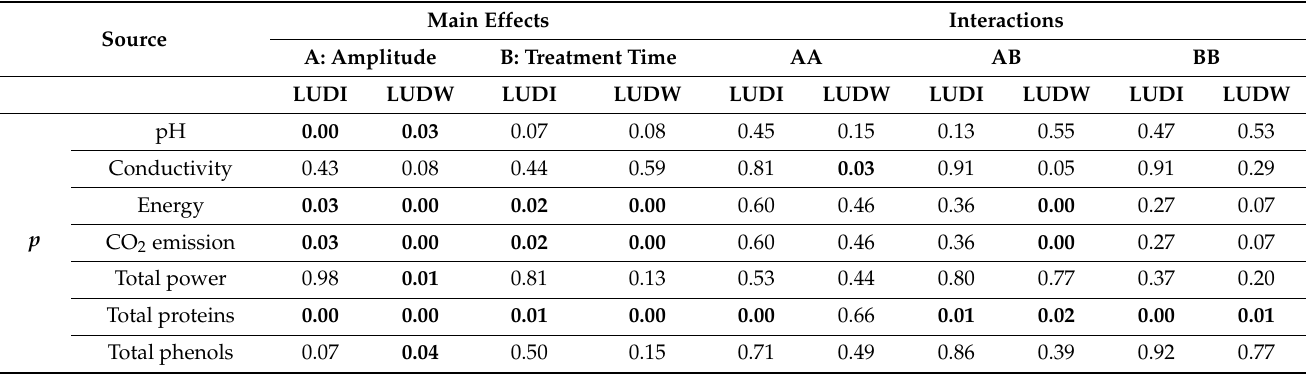
Table 7. Statistical significance for pH, conductivity, energy, CO 2 emission, power, total proteins, and total phenols. MANOVA statistically processes the variability of each input parameter, their mutual interactions, and quadratic interactions on the output values of LUDI and LUDW